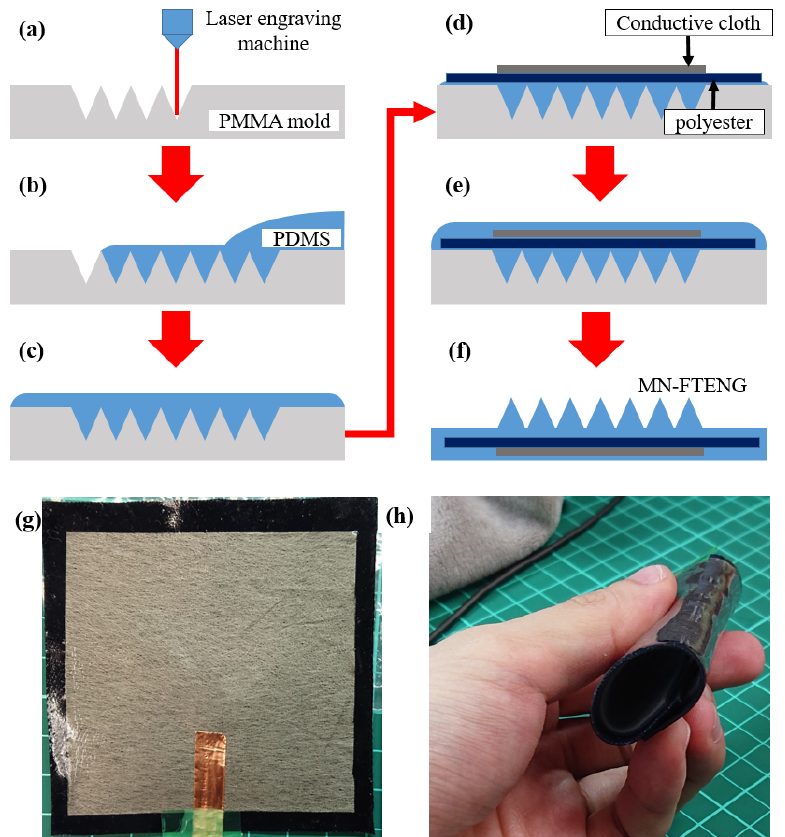
Figure 1. The process of preparing MN-FTENG and the appearance of MN-FTENG in this experiment: ( a ) Microstructures were fabricated on the PMMA mold with a laser engraving machine, ( b ) PDMS was poured into PMMA mold, ( c ) air bubbles was evacuated from PDMS in a vacuum chamber, ( d ) Lay polyester and conductive cloth on PDMS, ( e ) let PDMS fully penetrate into fiber in the vacuum chamber, ( f ) after baking and demolding, MN-FTENG is formed, ( g ) the appearance of MN-FTENG and ( h ) MN-FTENG can still be used after bending 360 degrees.